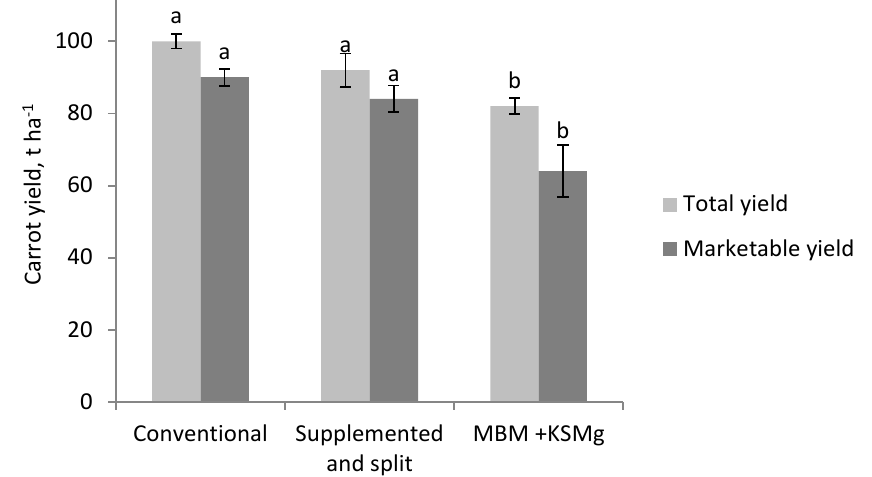
Fig. 3. Total root yield and marketable root yield of carrot by different fertilizations in 2010. (Error bars: ± standard error. Different lowercase letters above columns indicate significant ( p =0,05) differences between the means.